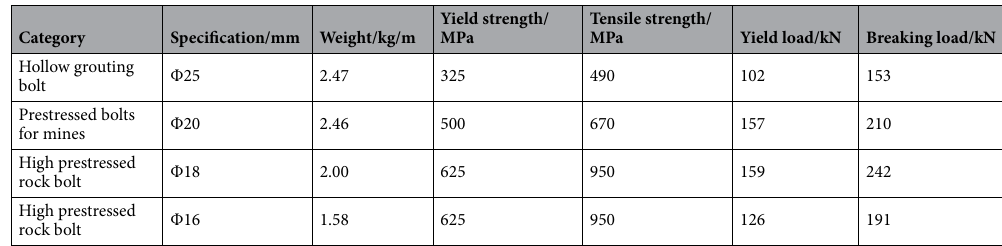
Table 5. Comparison table of traditional rock bolts and prestressed rock bolt.